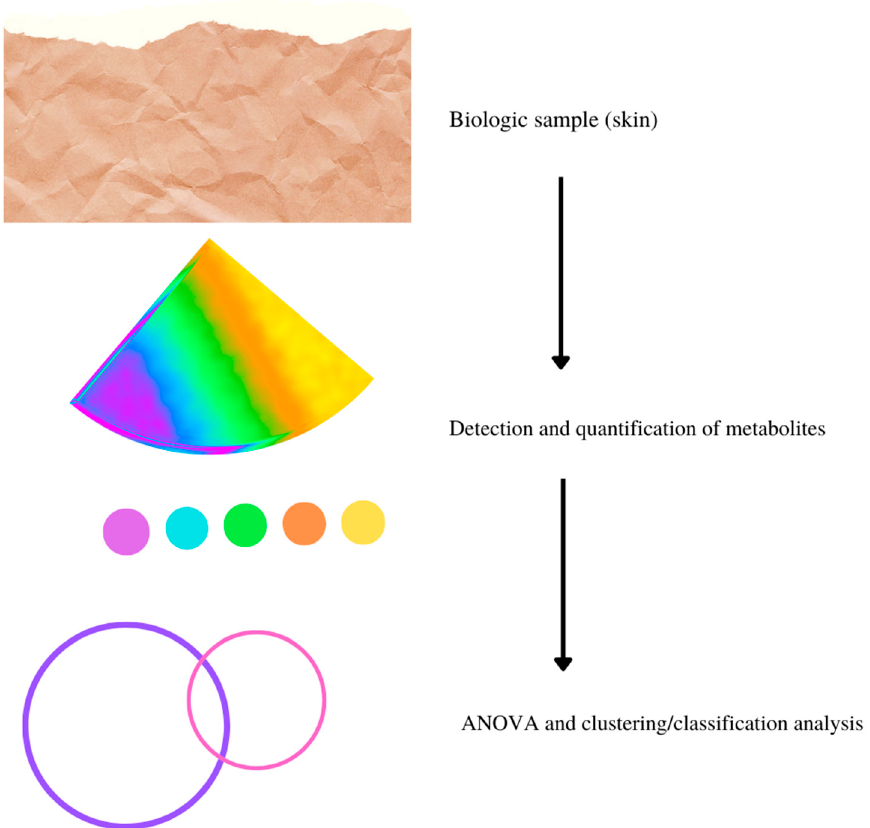
Figure 1. Typical workflow of metabolomic assessment in dermatology.